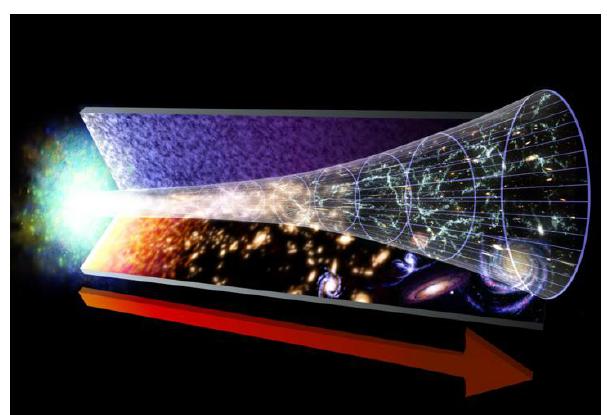
Figure 1. This image represents the evolution of the Universe, starting with the Big Bang. The red arrow marks the flow of time. Credit: